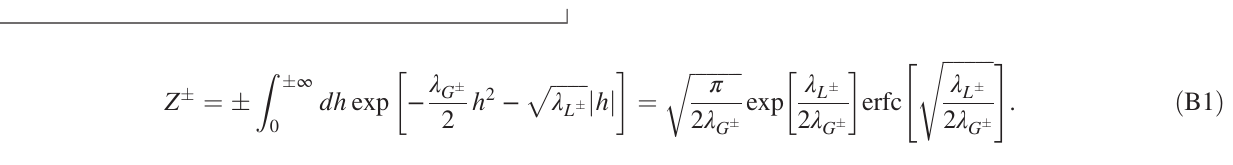
the thick rim, compared to the amplitudes of 41 nm in the center. Data presented in Fig. 9 are acquired after RBCs sedimented on a substrate, by measuring the fluctuations of the rim on the upper/distal membrane [23].